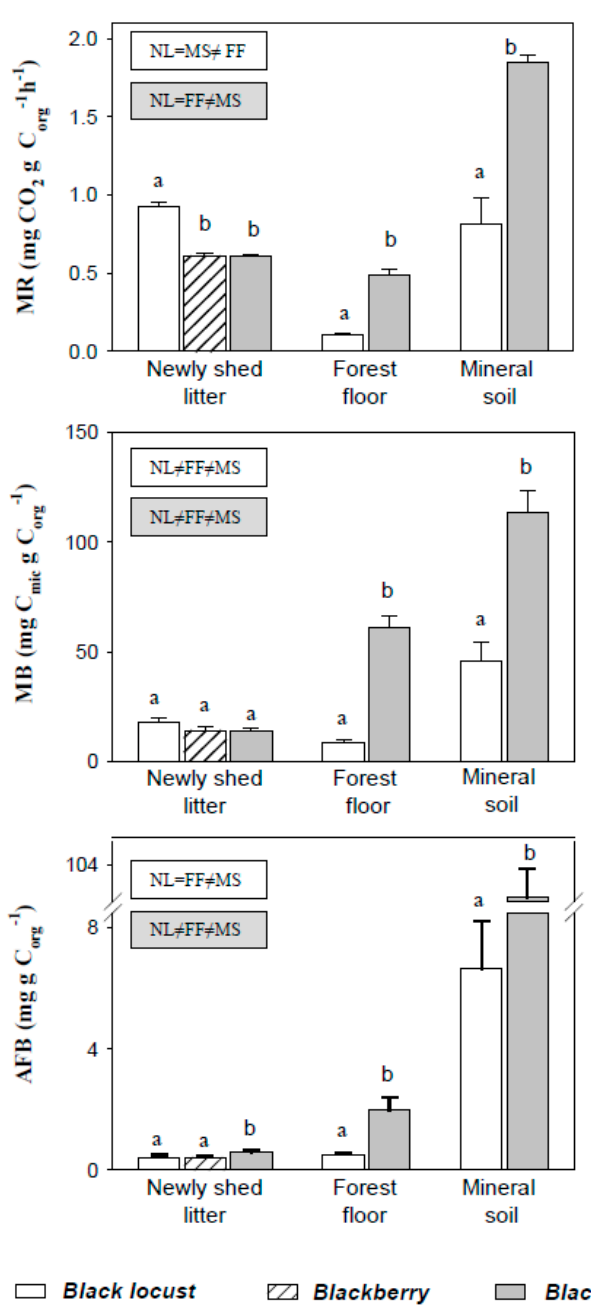
Figure 1. Mineralization rates (MR), microbial biomass (MB) and active fungal biomass (AFB) for Newly-shed leaf litter, Forest-floor litter, and Mineral soil collected in two 40-year-old paired forest stands at Mount Vesuvius. Data are reported as the mean ( ± SE) from 10 samples for newly-shed litter and 20 samples for forest-floor litter and mineral soil of 0–5 cm depth. Different lowercase letters indicate statistically significant differences ( p < 0.05) between types of newly-shed litter and between stands for forest floor and mineral soil.